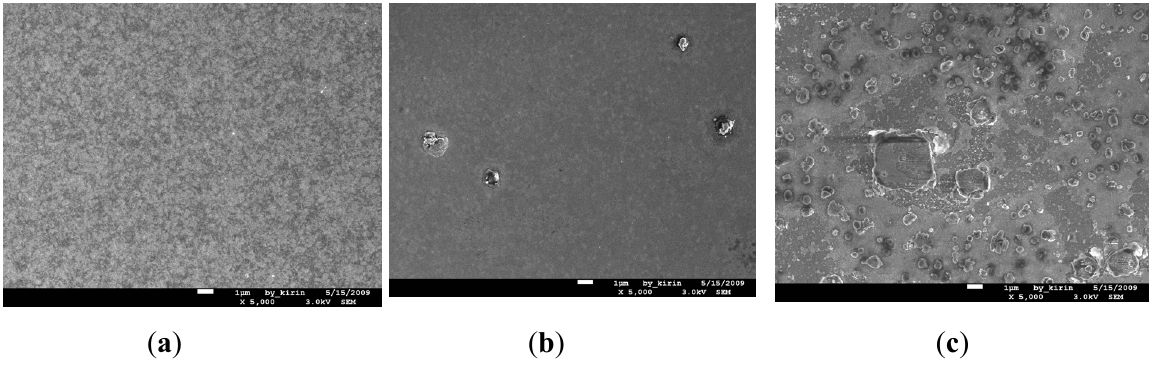
Figure 10. SEM views for the surface morphologies of structures of MgO (2 nm) sample annealed for 5 min at temperatures 700 °C ( a ); 750 °C ( b ); and 800 °C ( c ); respectively. 2.3. Cu (50 nm)/Ru (2 nm)/MgO (1 nm)/Ta (2